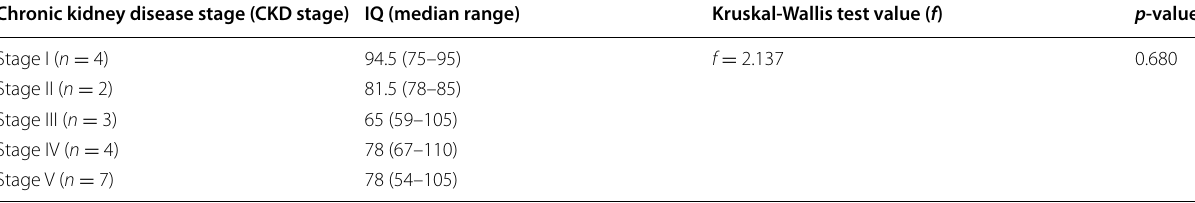
Kruskal-Wallis test was used for mean difference between groups (f)